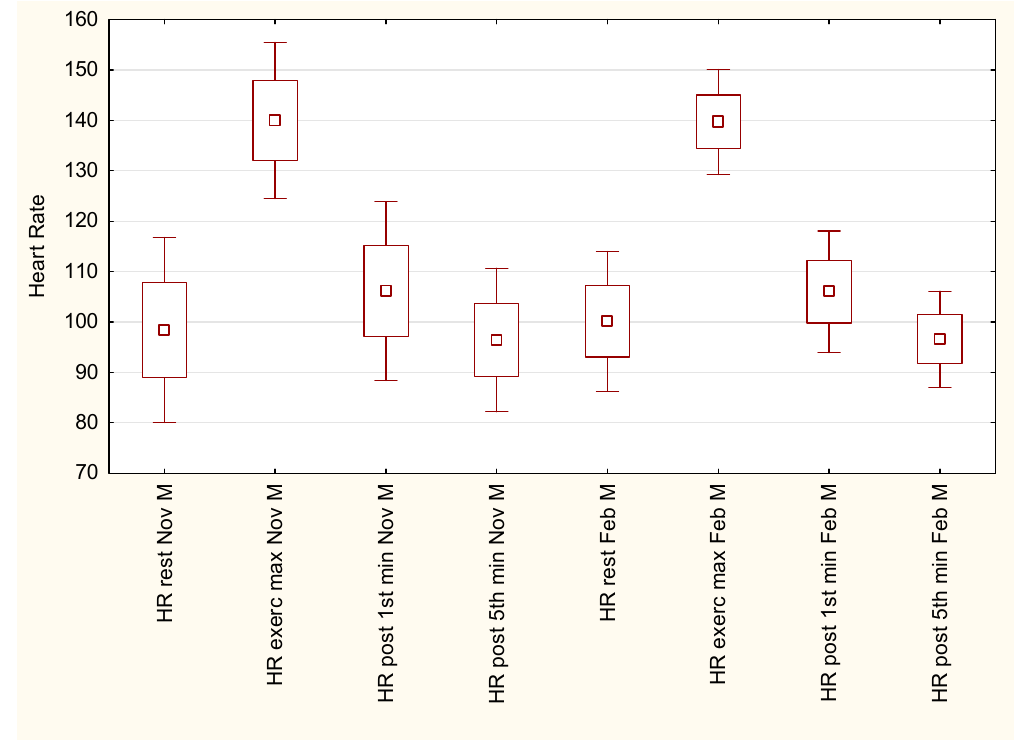
Figure 2. Heart-rate variation in male students in autumn and winter sessions of Physical Work Capacity 170 test.